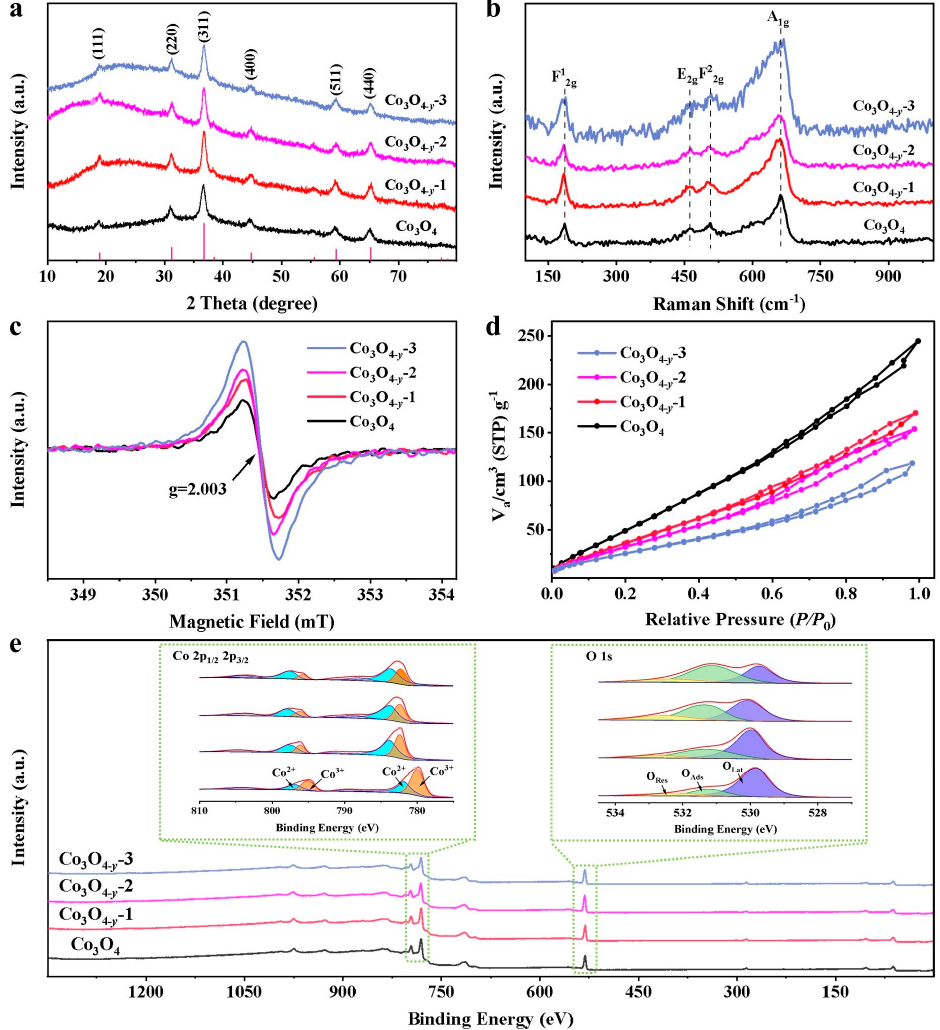
Figure 2. Characterizations of the materials. ( a ) XRD patterns, ( b ) Raman spectra, ( c ) EPR spectra, ( d ) N 2 adsorption–desorption isotherms, and ( e ) XPS spectra of Co 3 O 4 and Co 3 O 4- y − x ( x = 1, 2 and 3). Inset of Figure 2e: high resolution XPS Co 2p 1/2 and 2p 3/2 , O 1s spectra. X-ray photoelectron spectroscopy (XPS) was performed to further evaluate the elemental compositions and their oxidation states of Co 3 O 4 and Co 3 O 4- y − x ( x = 1, 2 and 3).